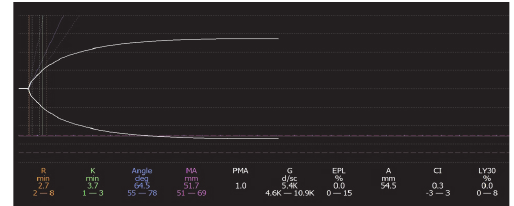
Figure 1: Thromboelastogram during preanhepatic phase after surgical incision.